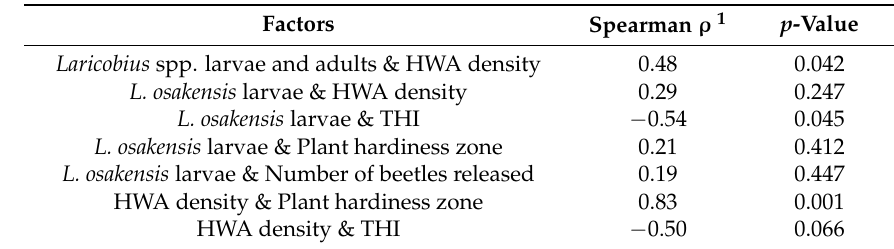
Table 3. Results of a nonparametric Spearman’s rank correlation analysis between L. osakensis or HWA density and selected sampling site